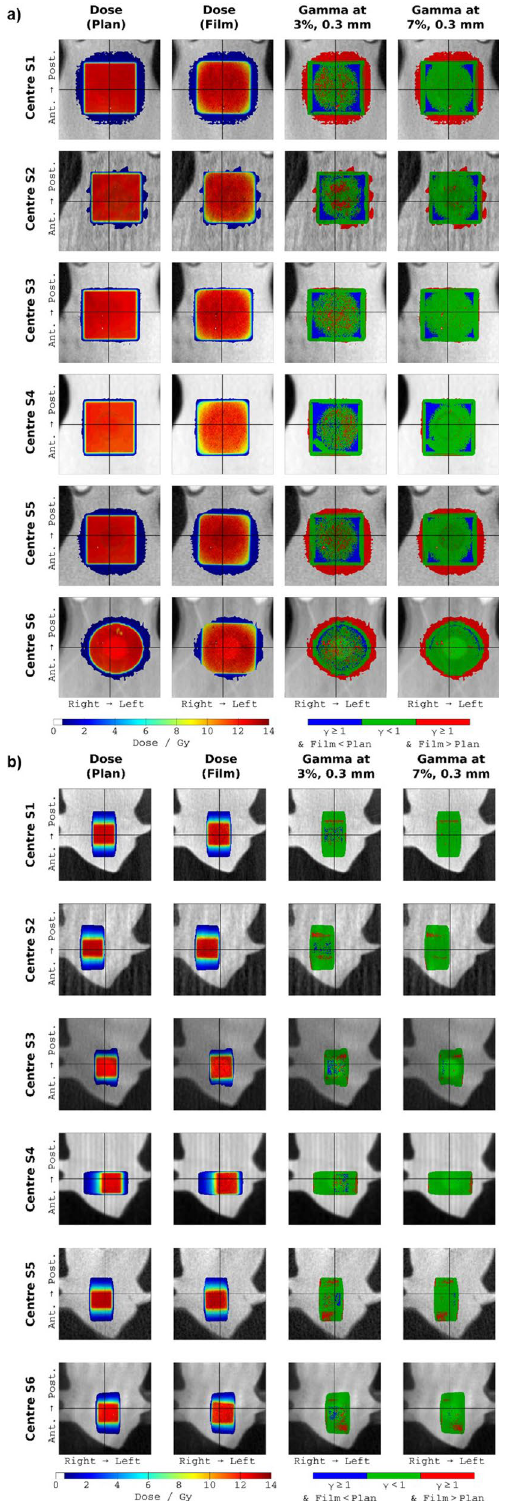
Figure 6. Results of the gamma analyses. ( a ) Results of the gamma analyses for one film from each centre for the static plan. Each row presents results for one centre (S1–S6). The columns present the planned dose, the film dose, and the gamma results at 3%, 0.3 mm and 7%, 0.3 mm, respectively. Each image has dimensions of 20 × 20 mm. ( b ) Results of the gamma analyses for one film from each centre for the arc plan. Each row presents results for one centre (S1–S6). The columns present the planned dose, the film dose, and the gamma results at 3%, 0.3 mm and 7%, 0.3 mm, respectively. Each image has dimensions of 20 × 20